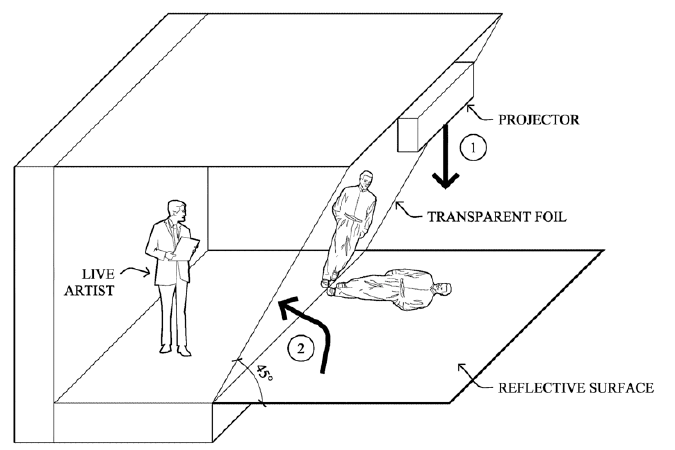
Figure 8. Pepper’s Ghost illusion based on projector and tilted beamsplitting mirror, showing how a real and a virtual person can appear to share a stage. From [21].